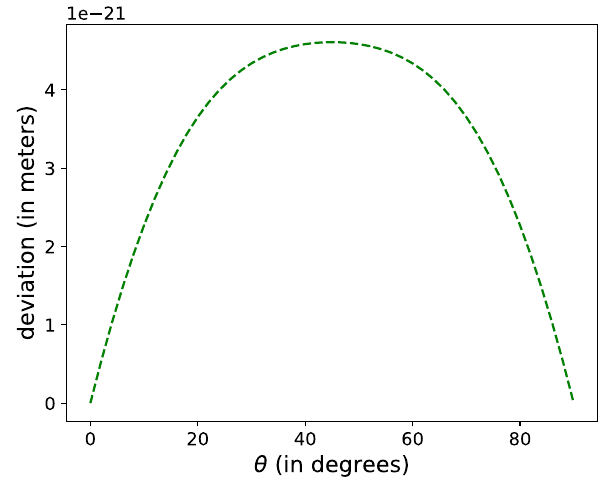
Fig. 2 Absolute deviation from an